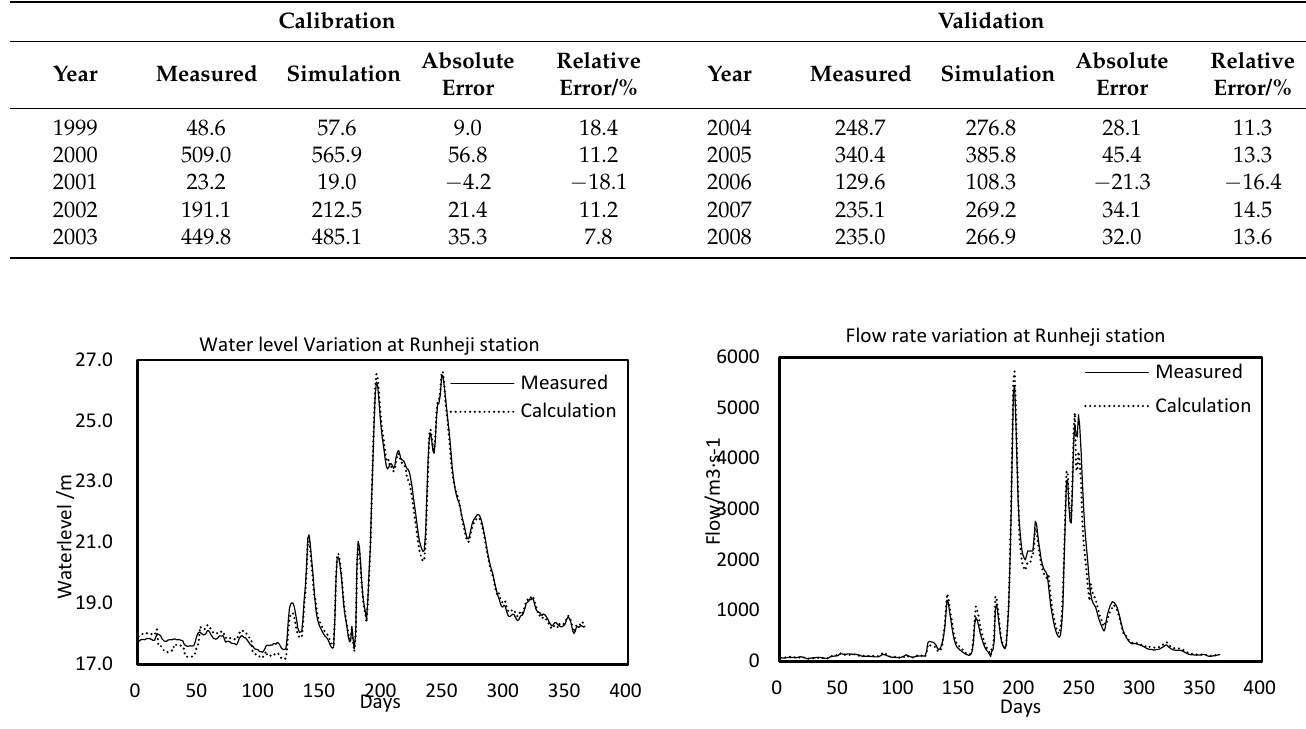
Figure 3. Comparison of water level and flow process at Run River station in 2005.